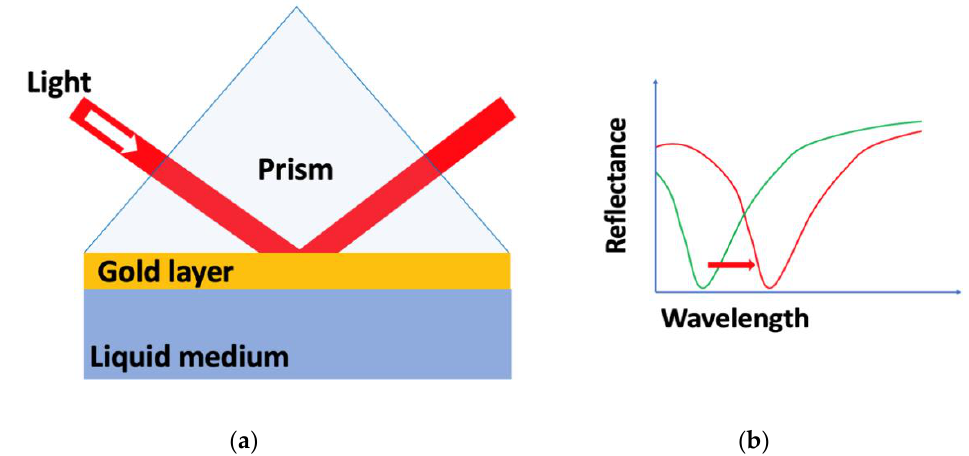
Figure 2. ( a ) Surface plasmon resonance biosensor based on the attenuated total reflection (ATR) method and ( b ) spectrum shifts observed before and after change in the refractive index as the result of a biorecognition event.